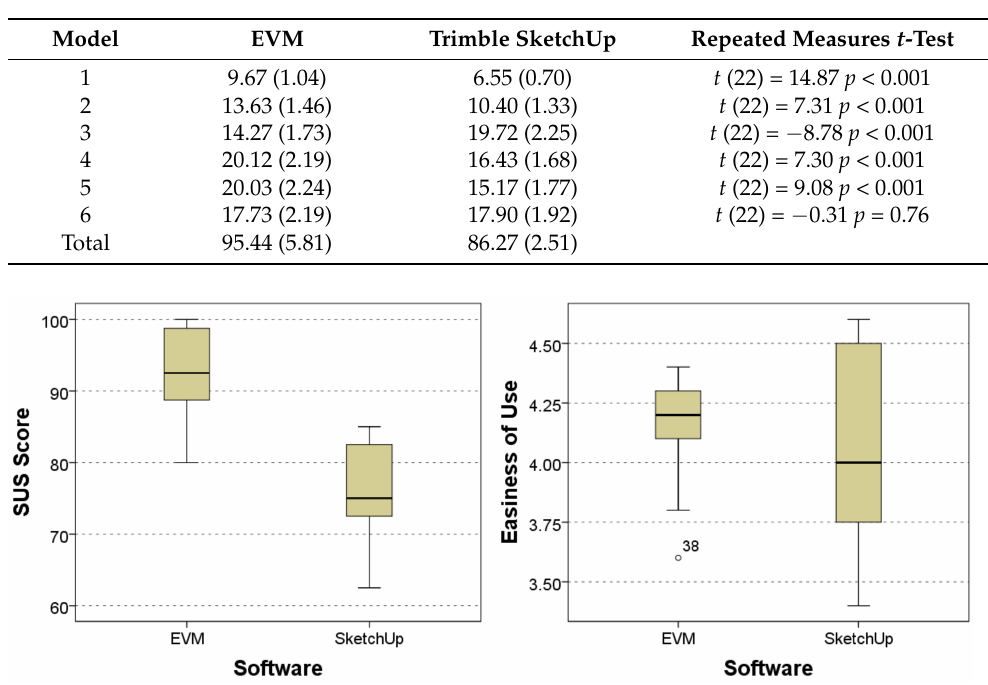
Table 8. Mean execution time (in minutes) per model and total, std. deviation, and t -test results.